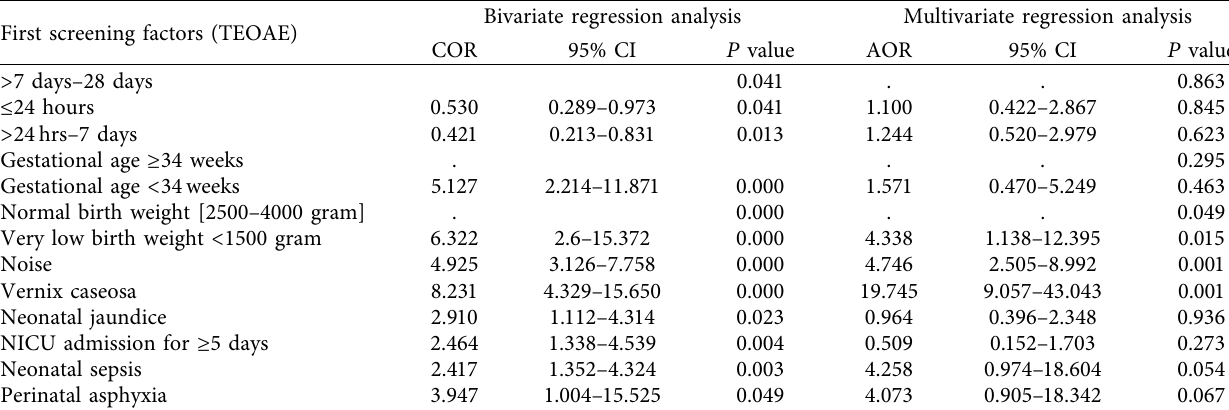
Table 2: Bivariate and multivariate regression analysis of factors associated with the first screening outcome of TEOAE